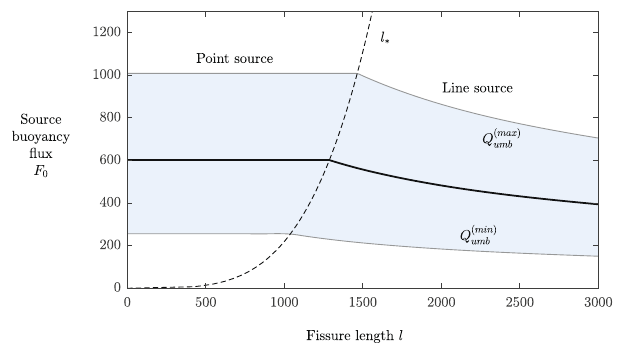
Fig. 5 Inferred buoyancy fl ux as a function of fi ssure length, illustrating the transition from a point-source model for the plume stem to a line- source model. The blue shading represents the range of inferred values of the buoyancy fl ux at the plume source F 0 given the full range of umbrella fl uxes, Q ð min Þ Q umb < Q ð max Þ , predicted by Eq. (4), as a function of the length umb < umb of the source l . For a point source, or suf fi ciently small fi ssure lengths ( l ≲ l * ), the details of the source are unimportant to good approximation and the predictions conform to those of a point-source model, as given by Eq. (9). For suf fi ciently long sources ( l ≳ l * ), a model assuming a planar source becomes more applicable in accordance with the prediction of Eq. (11). The lengthscale l * , given by Eq. (12) and indicated by a dashed curve, represents the fi ssure length on which the predictions of the two theories are